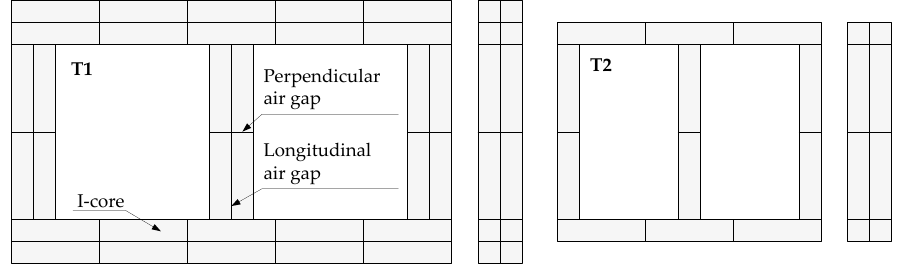
Figure 3. Medium frequency transformer core assembly composed of elementary I-cores: T1 ( left ) and T2 ( right ).